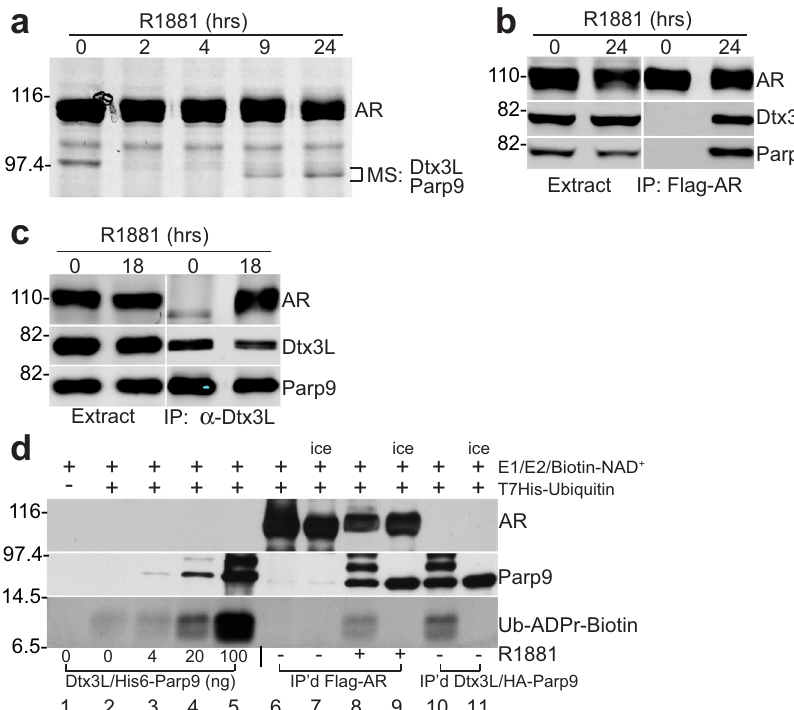
Fig. 1 Androgen induces assembly of AR-Dtx3L/Parp9 complexes. a PC3-AR cells were treated with the synthetic androgen R1881 for the indicated times. AR was isolated by IP, and the protein complexes were examined by SDS-PAGE and silver staining. The proteins migrating slightly faster than Hsp90 were identi fi ed as Dtx3L and Parp9 by mass spectrometry (MS). b AR IP ’ s from R1881-treated PC3-AR cells immunoblotted for AR, Dtx3L, and Parp9. c Dtx3L IP ’ s from R1881-treated PC3-AR cells immunoblotted for AR, Dtx3L, and Parp9. d Biochemical assays for ubiquitin E3 and ADP-ribosyltransferase activities in AR-Dtx3L/Parp9 complexes. Lanes 1 – 5 contain negative and positive controls (buffer, recombinant Dtx3L/Parp9, E1, E2, biotin-NAD + ) for detection of Ub-modi fi ed Parp9 and ADP-ribosylated ubiquitin. Lanes 6 – 9 contain AR IP ’ s from control and R1881-treated cells incubated at 30 °C, or on ice to block the reaction. Lane 8 shows that Dtx3L/Parp9 bound to AR has E3 activity (Ub-induced mobility shift of Parp9) and mono-ADP-ribosyltransferase activity towards Ub detected via ADPr-biotin. Lane 10 shows the levels of E3 and ADP-ribosyltransferase activity detected in the Dtx3L/Parp9 directly isolated by IP. Source data are provided as a Source data fi